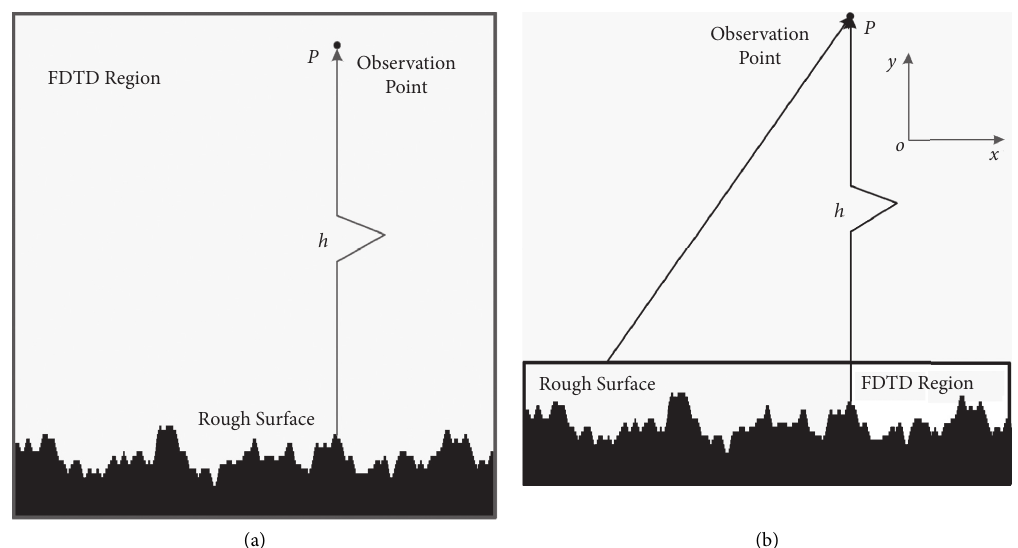
Figure 1: Comparison of the computational domain for the near-field scattering. (a) Traditional FDTD method. (b) Proposed hybrid